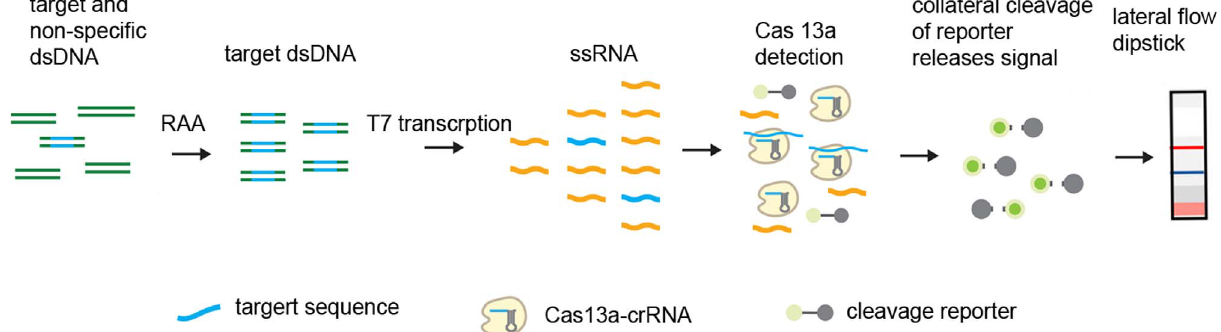
Figure 1. Schematic for T. gondii detection with the RAA-Cas13a-LFD assay. The procedures include ampli fi cation of target DNA with RAA; T7 RNA polymerase transcription of ampli fi ed DNA to RNA; target recognition of the target RNA with Cas13a-crRNA, collateral cleavage of fl uorophore-quencher reporter (i.e., lateral fl ow reporter) and release fl uorophore signal; visualization of the generated fl uorescence signal by lateral fl ow